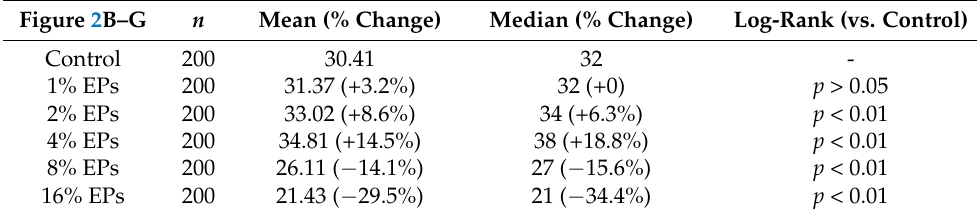
Table 2. Statistics of survival curves in Figure 2B–G. Cohort sizes, mean and median life spans, percentage changes, and log-rank tests of the Kaplan–Meier survival curves in this